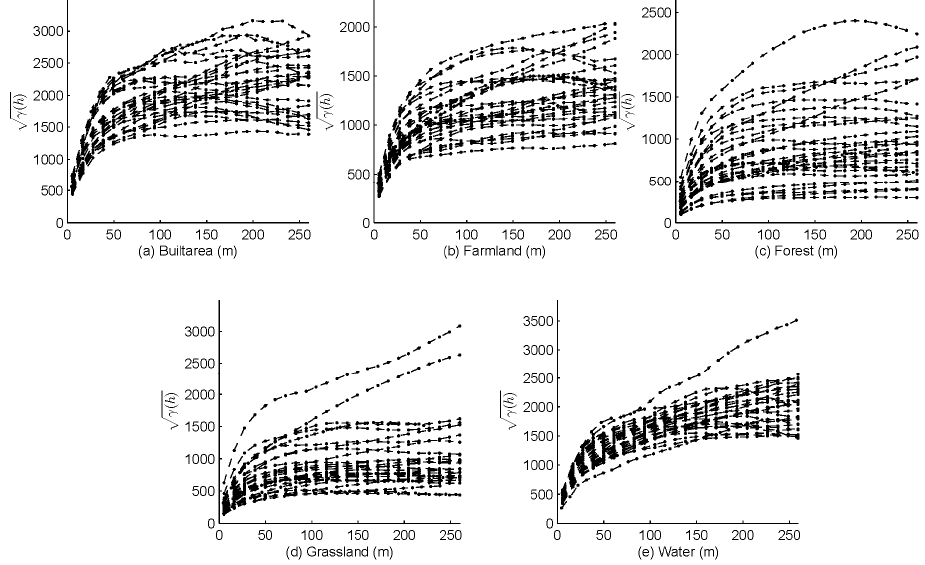
Figure 4. Semivariograms for: built area ( a ); farmland ( b ); forest ( c ); grassland ( d ); and water ( e ), via sub-area method (SAM).